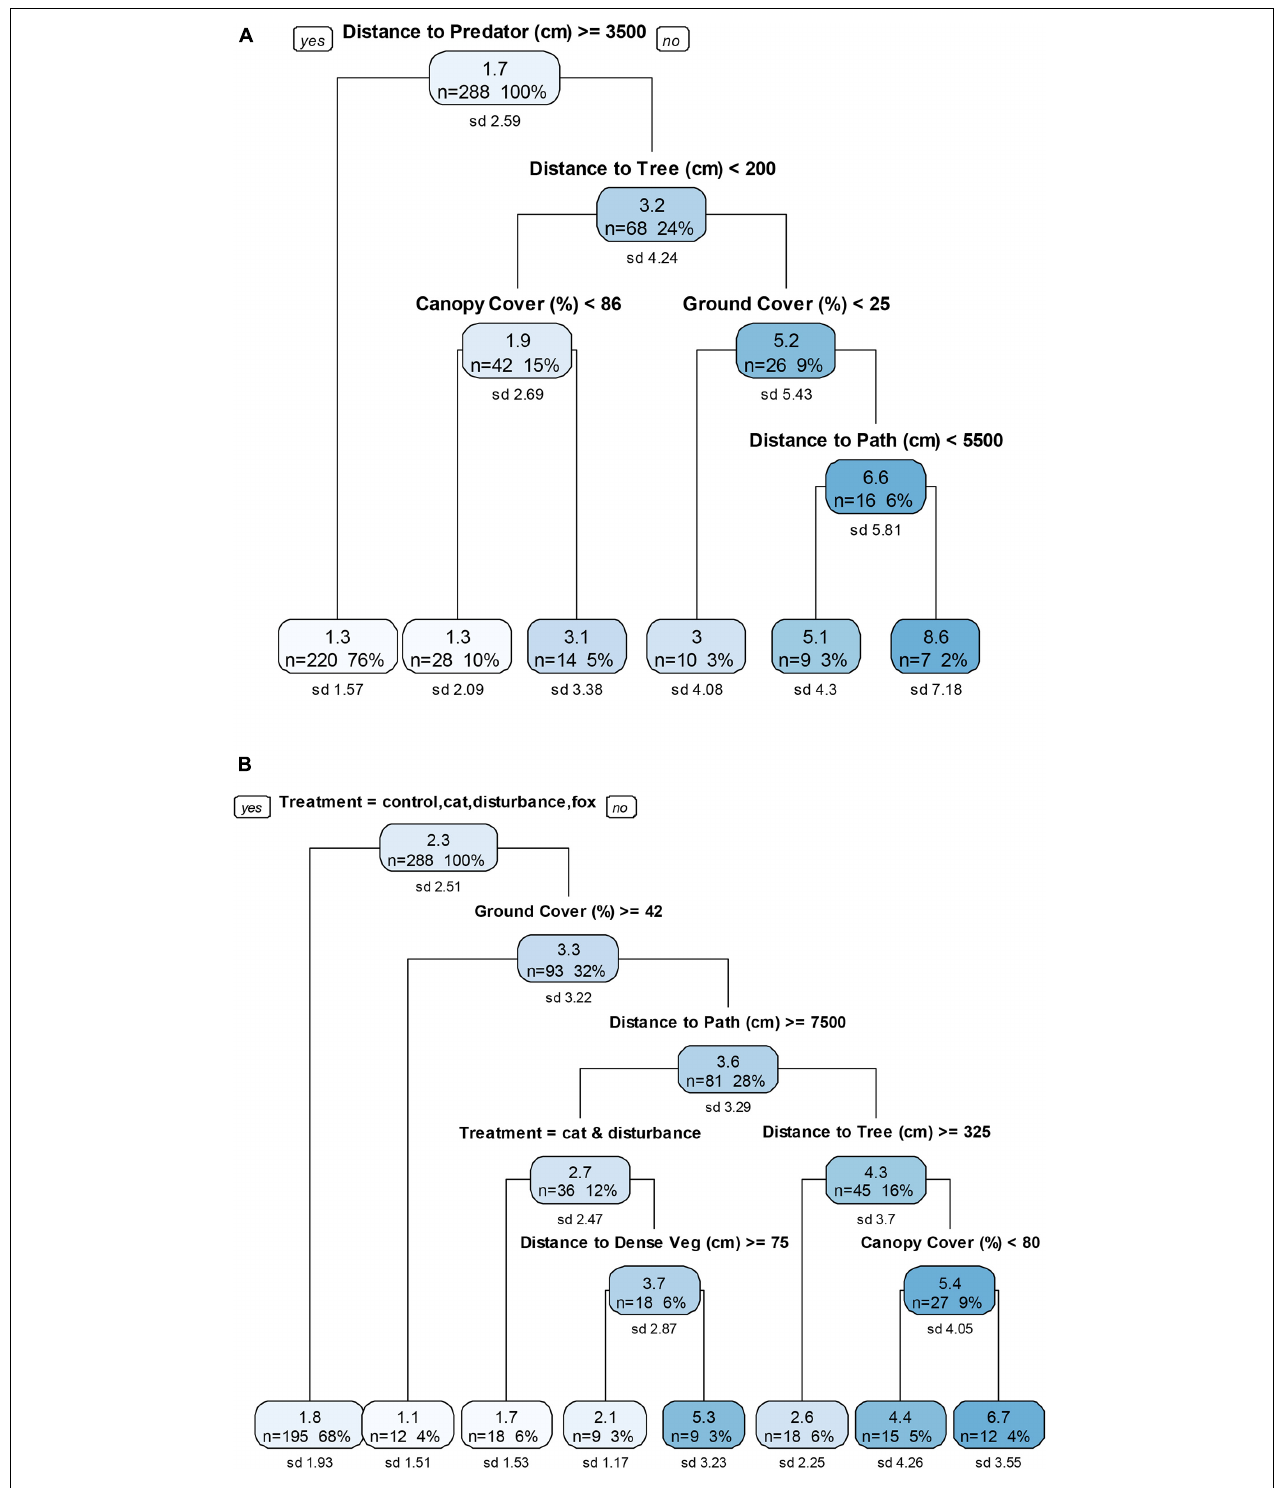
FIGURE 5 | Descriptive regression decision trees for four sessions of three nights each of (A) pre-treatment and (B) treatment giving-up density (GUD) trials at the far environment, a remnant rainforest in a conservation area. The top number in each node is the GUD, the mean number of mealworms left in the tray (after ∼ 12 h nocturnal exposure). The number of GUD station surveys included in the data split at each node is given by the “ n ” number. The “%” value is its corresponding percentage from the full data set ( n = 288). The standard deviation of the mean number of mealworms left at each node is given by the “sd” value. The six treatments in (B) included: control, domestic cat cue, red fox cue, human disturbance cue (sound and light), and combined human disturbance and cat or fox cues.